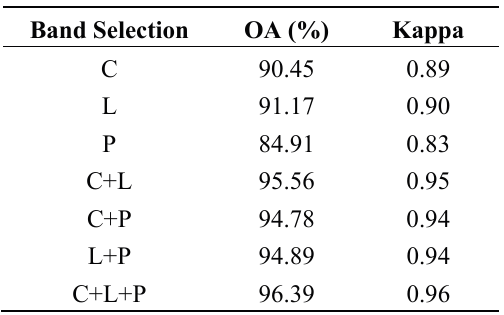
Table 9. Accuracy of Multi-Frequency Dataset.